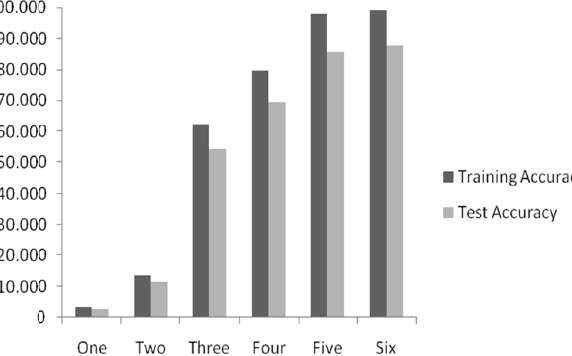
Fig. 1. Average accuracy values using different colour feature 1. Average accuracy values using different colour feature 1. Average accuracy values using different colour feature combinations combinations colour combinations. Increasing the number of colour colour combinations. Increasing the number of colour colour combinations. Increasing the number of colour colour combinations. Increasing the number of colour features led to higher accuracy values. Combination of features led to higher accuracy values. Combination of features led to higher accuracy values. Combination of features led to higher accuracy values. Combination of colour features was the most accurate combination with colour features was the most accurate combination with colour features was the most accurate combination with colour features was the most accurate combination